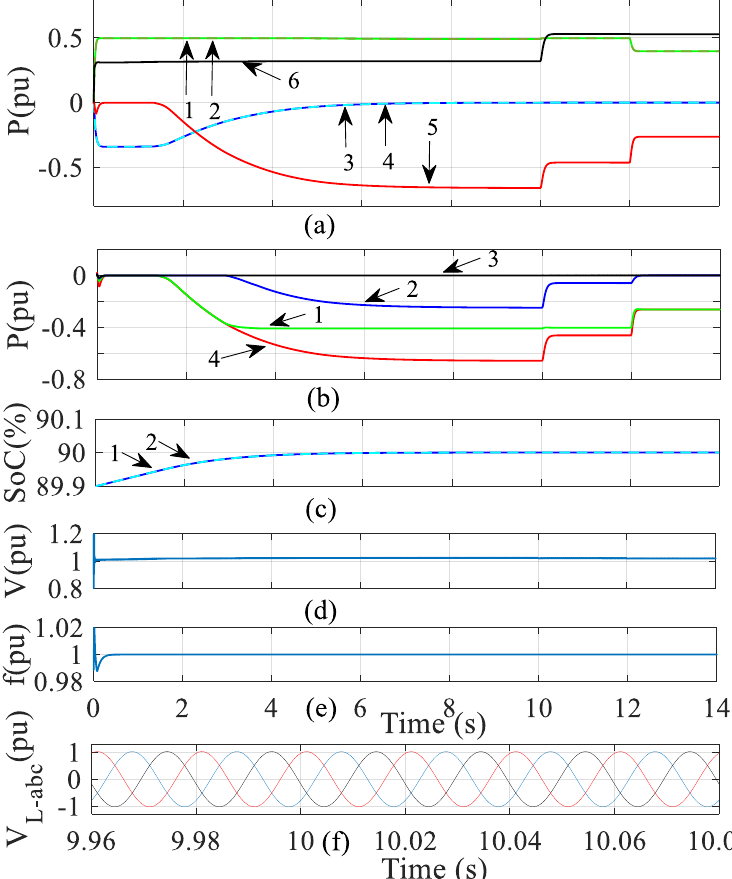
Figure 9. Hitting max. SoC limit. ( a ) Power (pu), 1 — P pv 1 ; 2 — P pv 2 ; 3 — P b 1 ; 4 — P b 2 ; 5 — P g ; 6 — P L . ( b ) power from MGSCs (pu), 1 — P g 1 ; 2 — P g 2 ; 3 — P g 3 ; 4 — P g . ( c ) SoC (%), 1 — SoC 1 ; 2 — SoC 2 . ( d ) V L (pu). ( e ) Load frequency (pu). ( f ) Instantaneous 3-phase load voltage zoomed-in at sudden load change ( t = 10 s) time (pu).